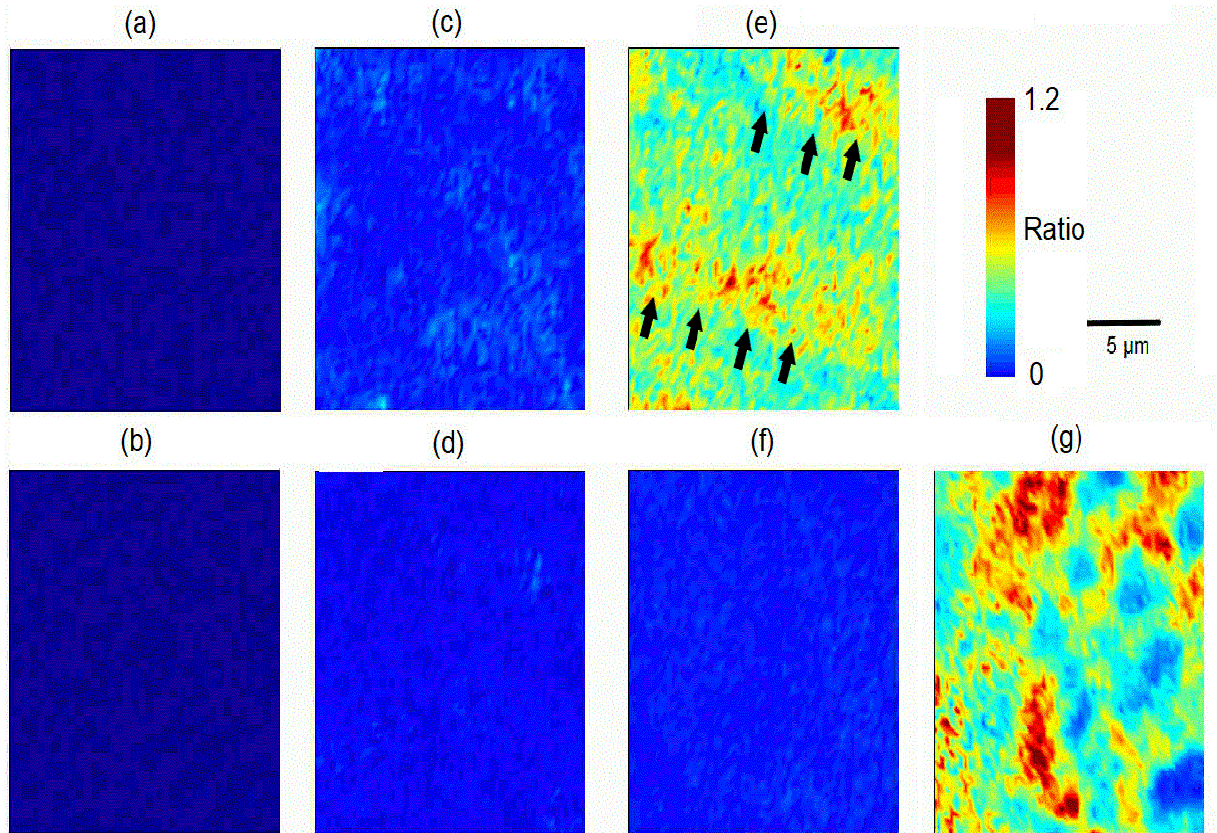
Figure 4. Color-scaled matrix-to-mineral ratios calculated from the Raman spectra at 960, 1450, and 1463 cm −1 : ( a ) enamel test sample; ( b ) enamel control sample; ( c ) dentin test sample; ( d ) dentin control sample; ( e ) dentin test sample with high density bands marked by black arrow heads; ( f ) respective dentin control sample; ( g ) biorepair ® toothpaste aliquot.